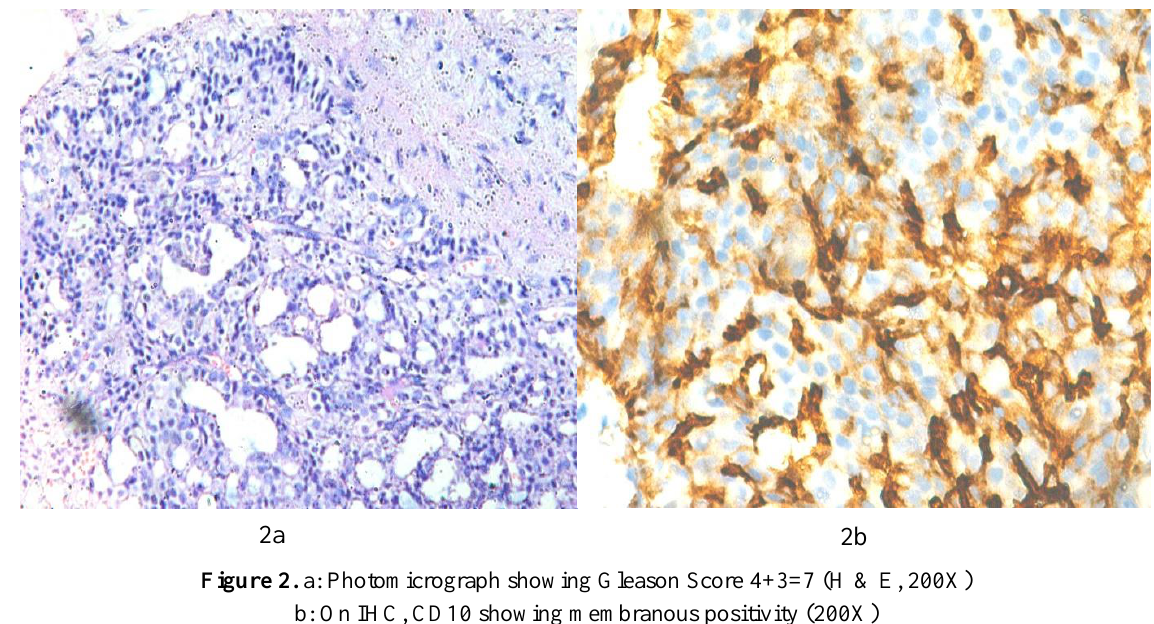
Figure 2. a: Photomicrograph showing Gleason Score 4+3=7 (H & E, 200X) b: On IHC, CD10 showing membranous positivity (200X)